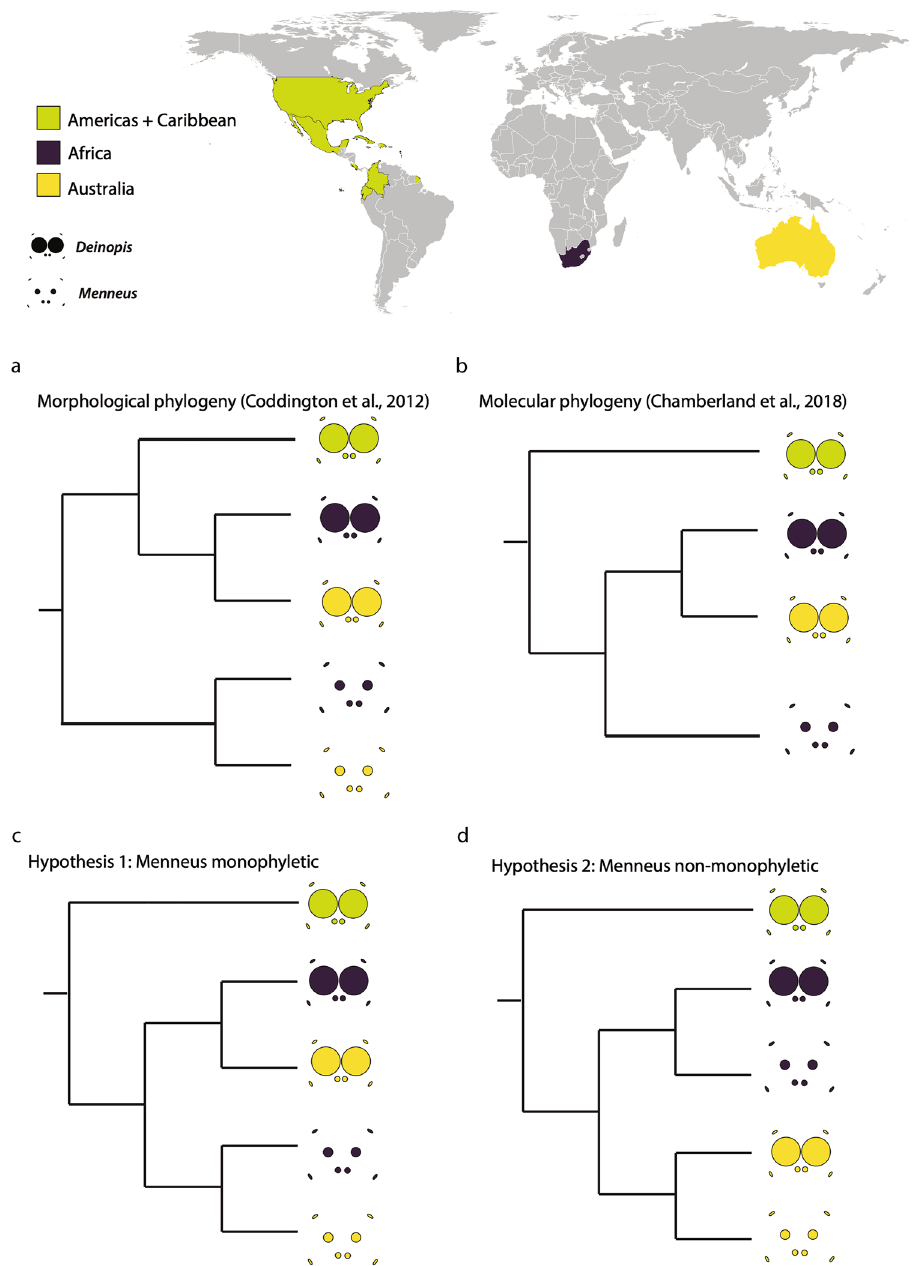
Figure 1. Main phylogenetic hypotheses of Deinopidae assessing the monophyly of Menneus. We included all alternative tree topologies, which include non-monophyly of Deinopis and Asianopis in Supplemental Fig. S1. Phylogenies are based on ( a ) morphological data, ( b ) incomplete molecular data. The two primary alternative hypotheses we tested with the addition of Menneus from Australia: ( c ) PME size is reduced once and ( d ) PME size is reduced twice, independently in Australian and South African Deinopis. Map was created using the base map form Wikimedia Commons (https:// commo ns. wikim edia. org/ wiki/ File: Blank Map- World. svg) and country colors were modified using Adobe Illustrator (https:// www. adobe. com/) (Map: Lisa